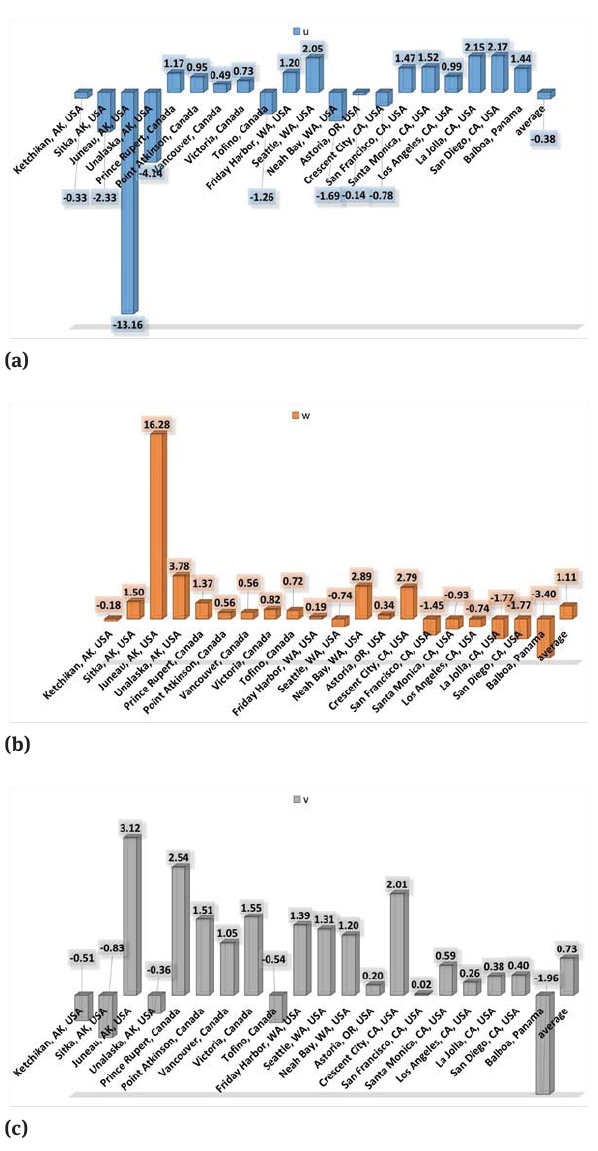
Figure 23: Summary of sea-level rise and subsidence results. u is the relative sea-level rise, w is the absolute vertical velocity at the GNSS antenna nearby the tide gauge, and v = u + w is the absolute sea-level rise. Units are